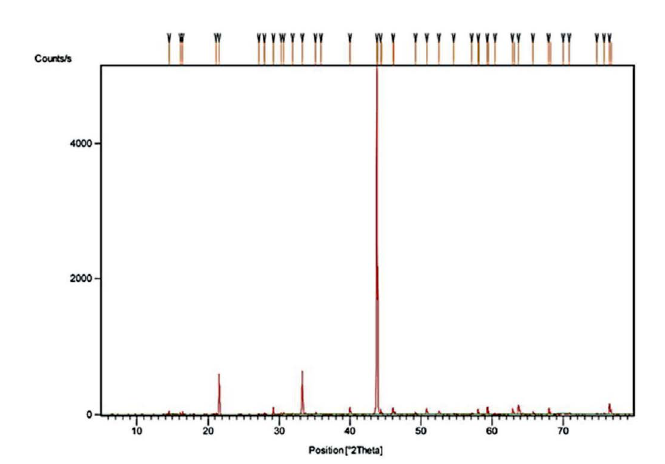
Fig. 3. X-ray diffraction powder pattern of struvite crystal.